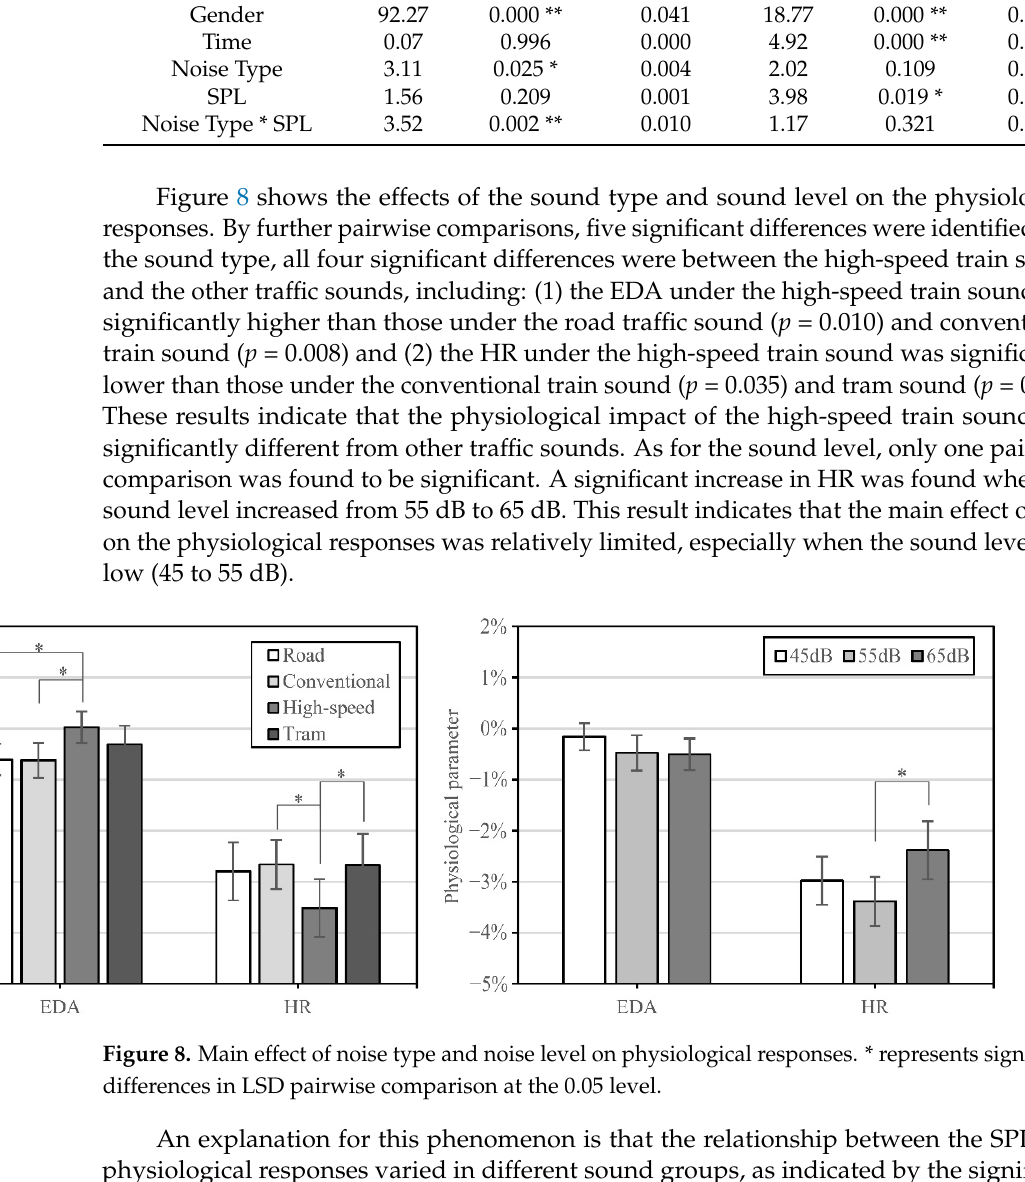
9 of 16 Figure 7. Effect of gender on psychological attributes. The vertical bars represent 95% confidence